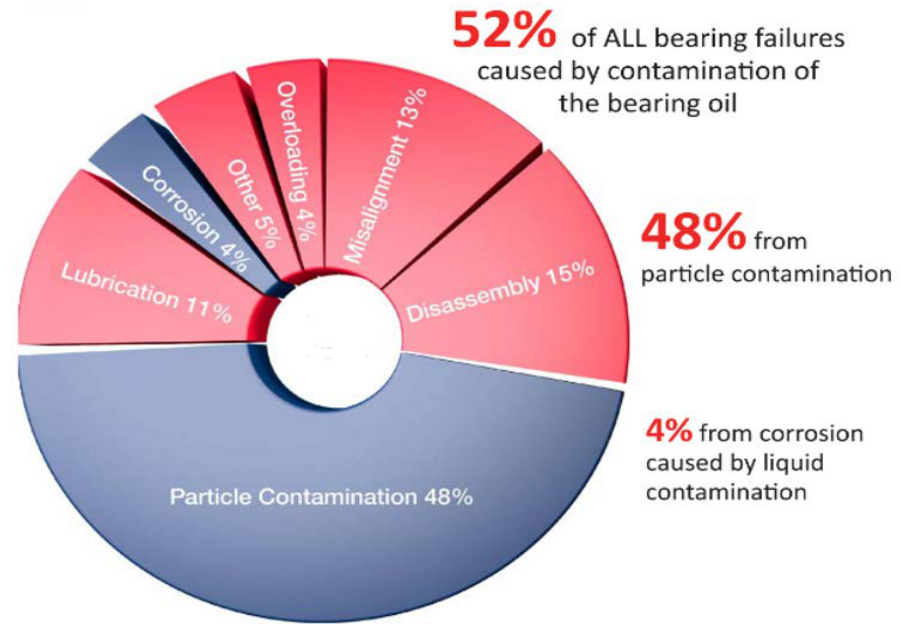
Figure 3. Causes of failures in rolling bearings.